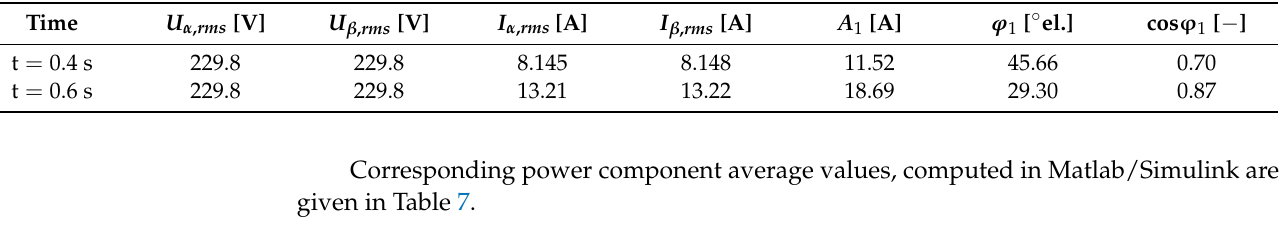
Table 6. Simulation results before and after the change (at steady states).